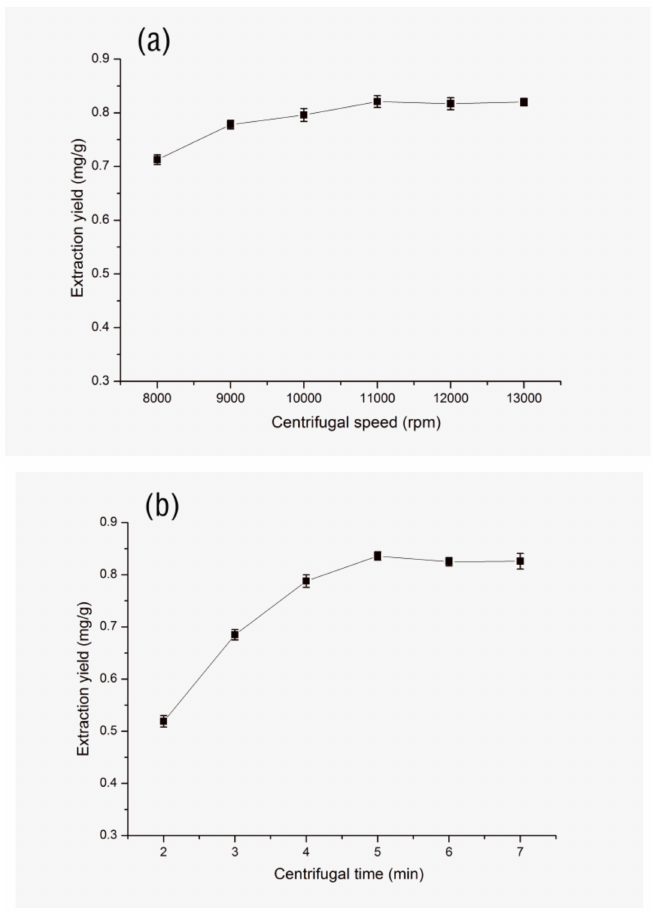
Figure 10. E ff ect of centrifugal speed ( a ) and time ( b ) on extraction yield of FA. Sample amount, 50 mg; type of IL, [C 4 mim]NTf 2 ; extraction temperature, 60 ◦ C; volume of IL, 0.8 mL; solid–liquid ratio, 1:40 (g / mL); ultrasonic time, 9